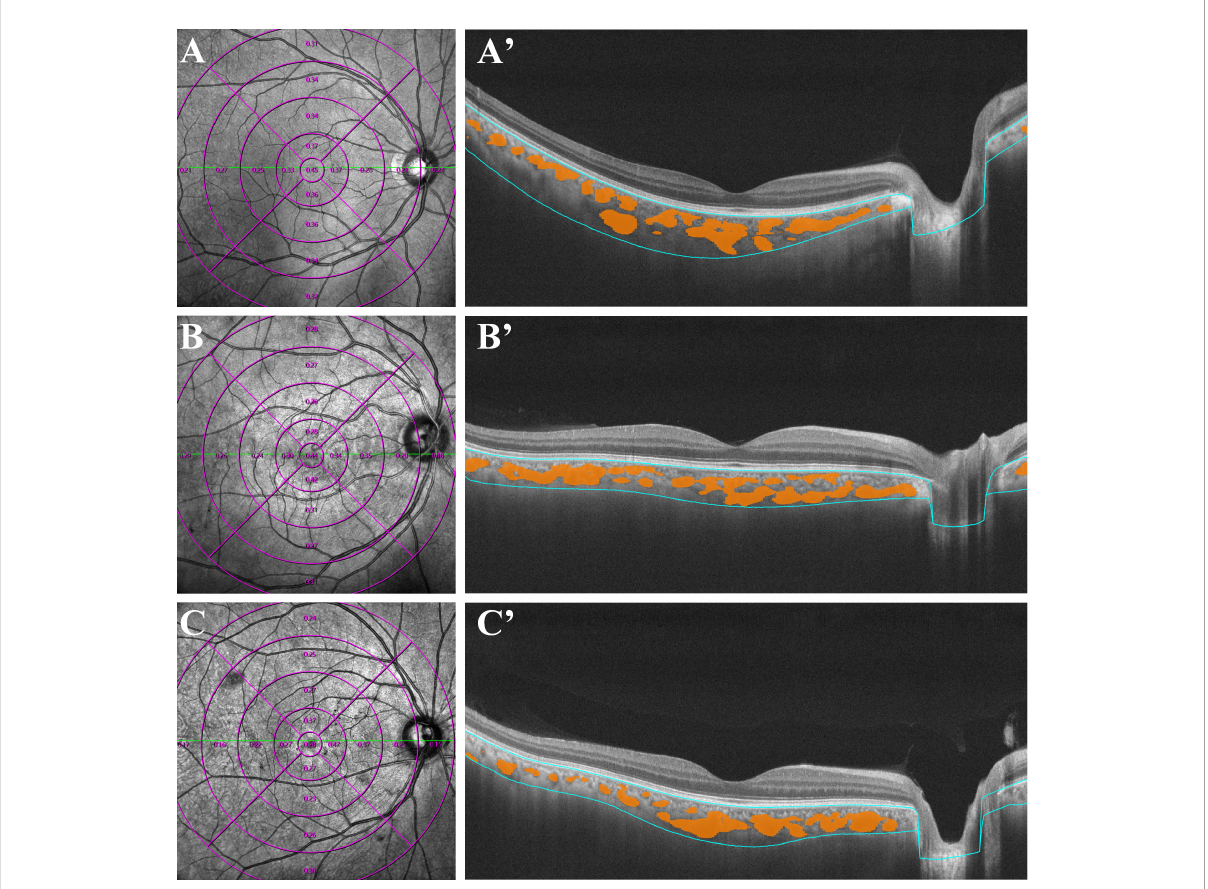
FIGURE 1 Examples of quantitative measurements of CVI using Wide- fi eld OCTA in patients with early-stage DR (C, C'), diabetes mellitus without DR (B, B') and normal control subjects (A, A'). The left column consists of en face infrared (12 ×12 mm) images. The right column represent the optical coherence tomography of the retina and choroid across the fovea, yellow marks represent the choroidal lumen, and the blue lines indicate the upper and lower bounds of the choroid. CVI, choroidal vascularity index; OCTA, optical coherence tomographic